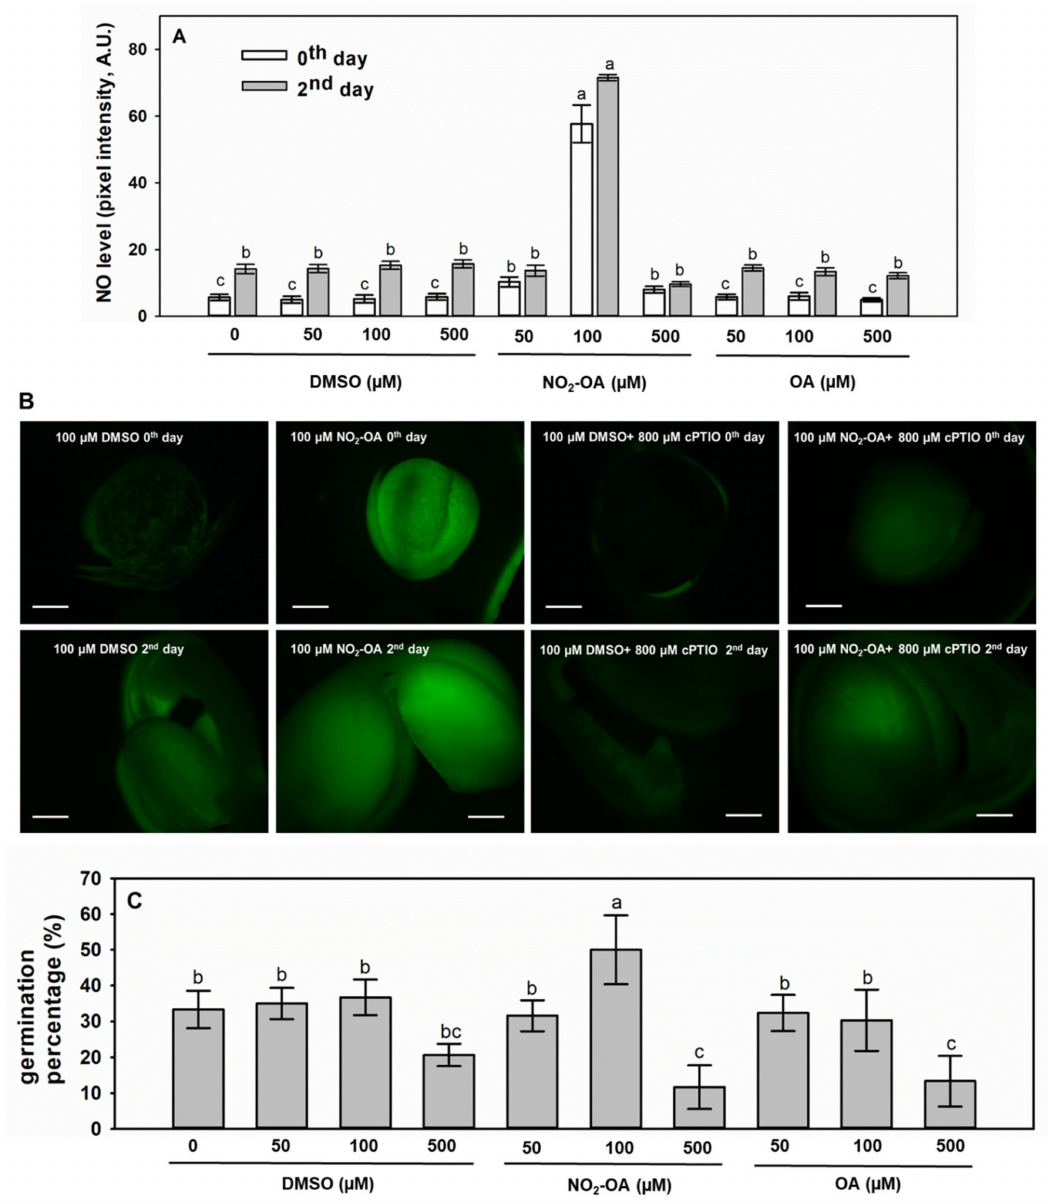
Figure 5. Exogenous NO 2 -OA increases endogenous • NO levels and triggers germination of Brassica napus seeds. ( A ) Nitric oxide level in seeds (day 0 of germination) and seedlings (2nd day after sowing) of Brassica napus treated for 24 h with 50, 100 or 500 µ M NO 2 -OA or with equal concentrations of OA. As controls, seeds were treated with 0, 50, 100 or 500 µ M DMSO. Di ff erent letters indicate significant di ff erences according to Holm–Sidak test (P ≤ 0.001). ( B ) Representative fluorescent microscopic images of DAF FM-stained Brassica seeds and seedlings treated with 100 µ M NO 2 -OA or 100 µ M DMSO for 24 h in the presence or absence of 800 µ M cPTIO. Bars = 800 µ m. ( C ) Germination percentage (determined at the 2nd day after sowing) of Brassica seeds treated with 50, 100, or 500 µ M NO 2 -OA or with equal concentrations of OA. As controls, seeds were treated with 0, 50, 100, or 500 µ M DMSO. Di ff erent letters indicate significant di ff erences according to the Holm–Sidak test (P ≤ 0.001). The germination percentages were altered in accordance with • NO levels, since 100 µ M NO 2 -OA treatment doubled the percentage of germinated seeds compared to control (100 µ M DMSO) (Figure 5C). DMSO alone at 50 µ M or 100 µ M concentrations had no effect on seed germination, although in the presence of 500 µ M DMSO germination percentage of Brassica seeds slightly decreased compared to control (0 µ